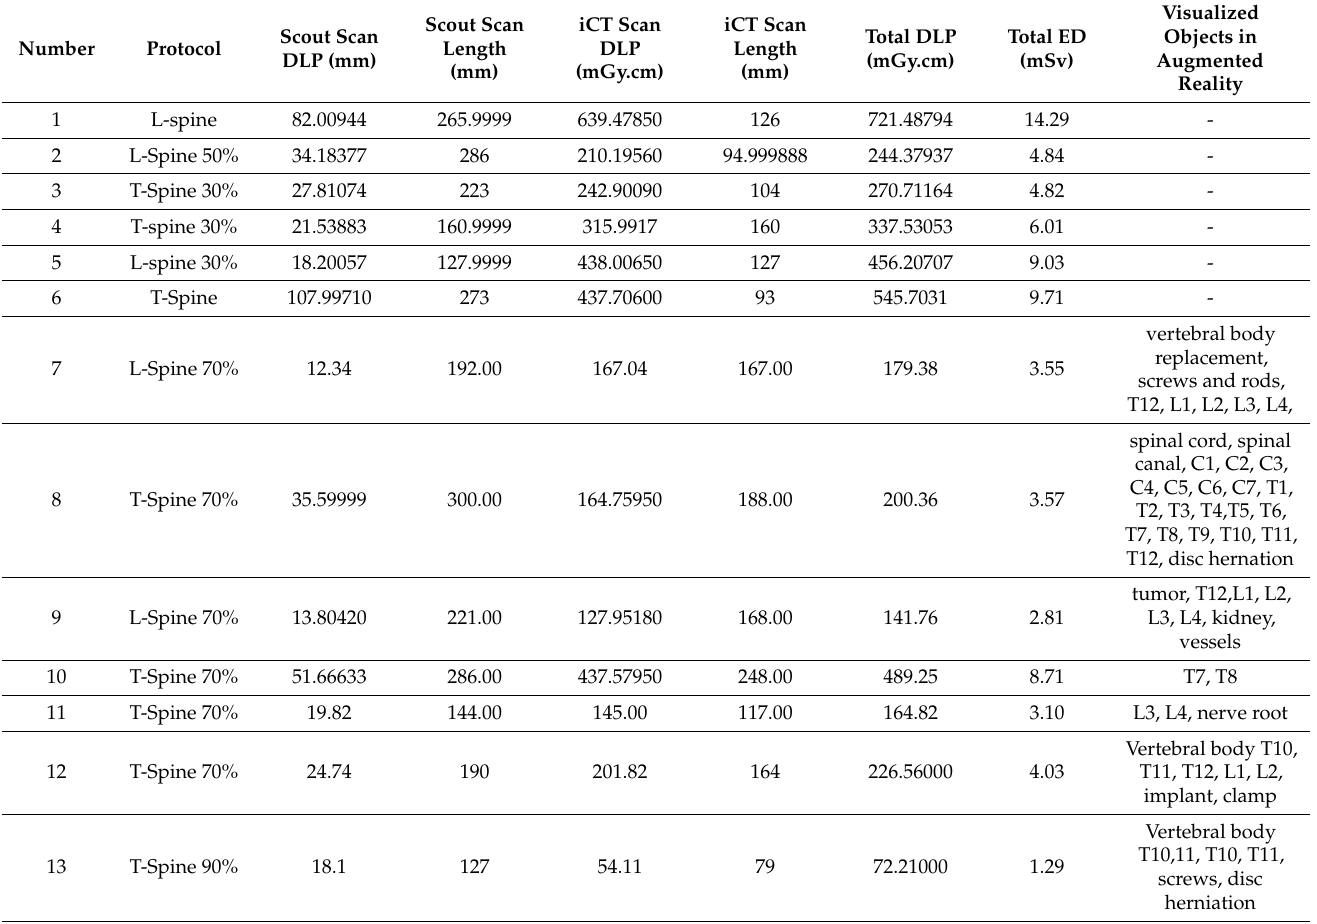
Table 2. Scan length and DLP of scout and registration scan, and total effective dose with fused image datasets with iCT registration and visualized objects in augmented